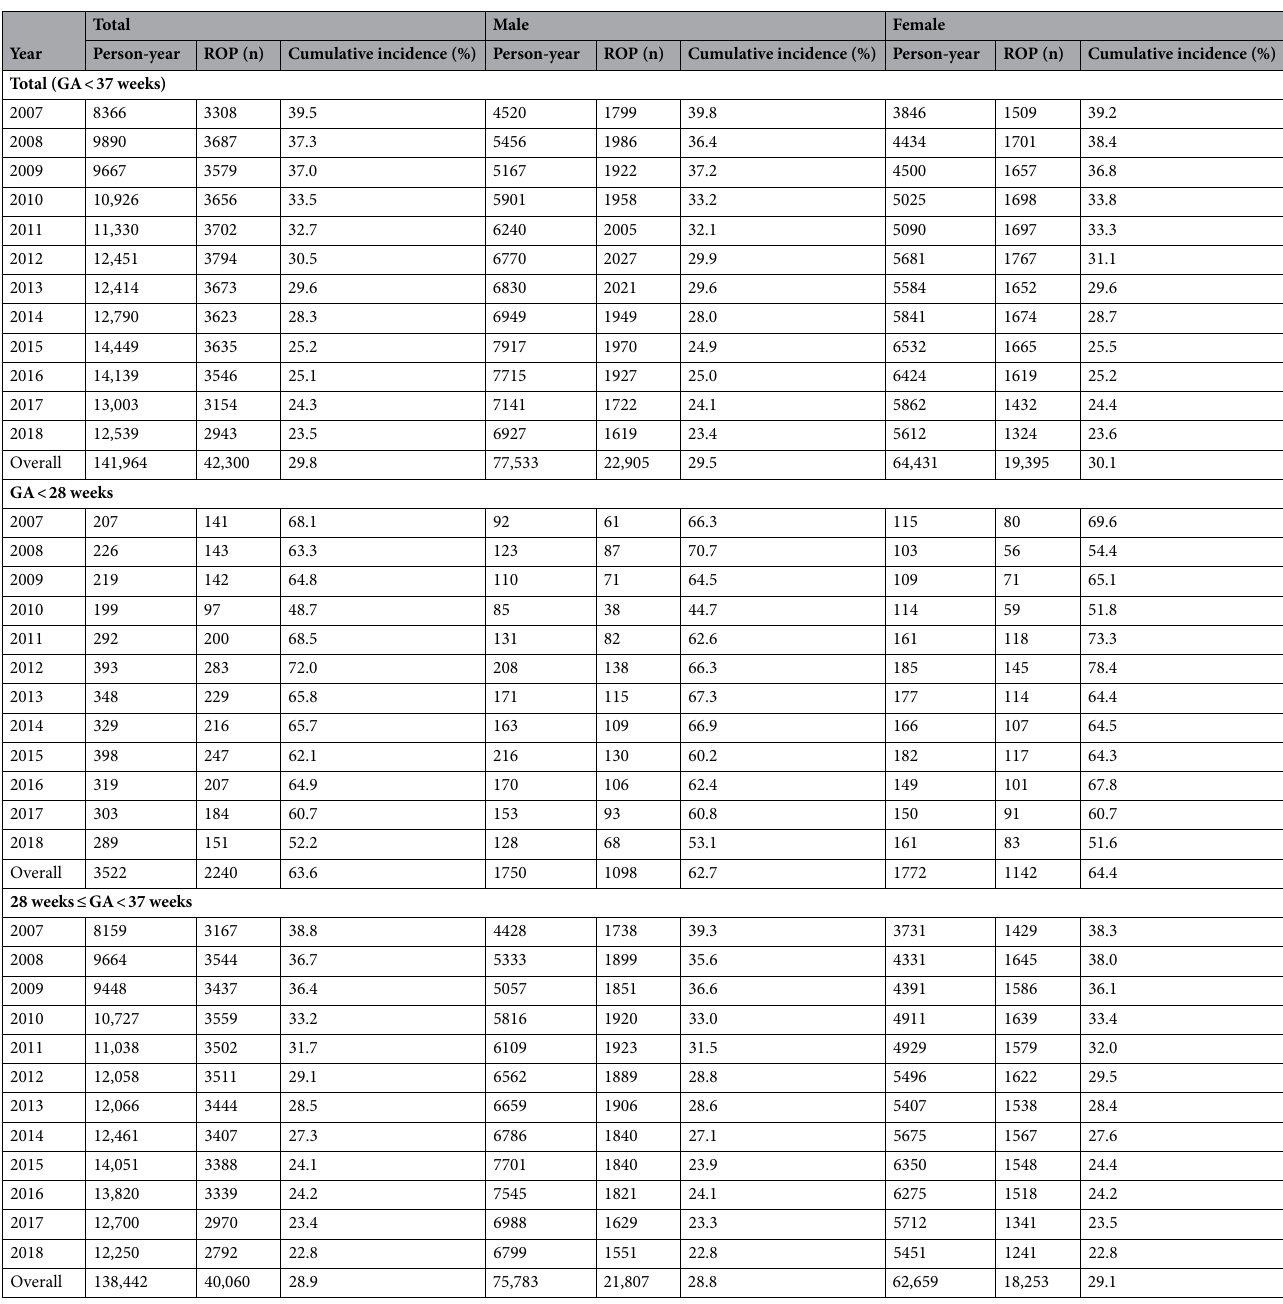
Table 1. The cumulative incidence of retinopathy of prematurity in premature infants from 2007 to 2018 according to gestational age and sex. GA gestational age, ROP retinopathy of